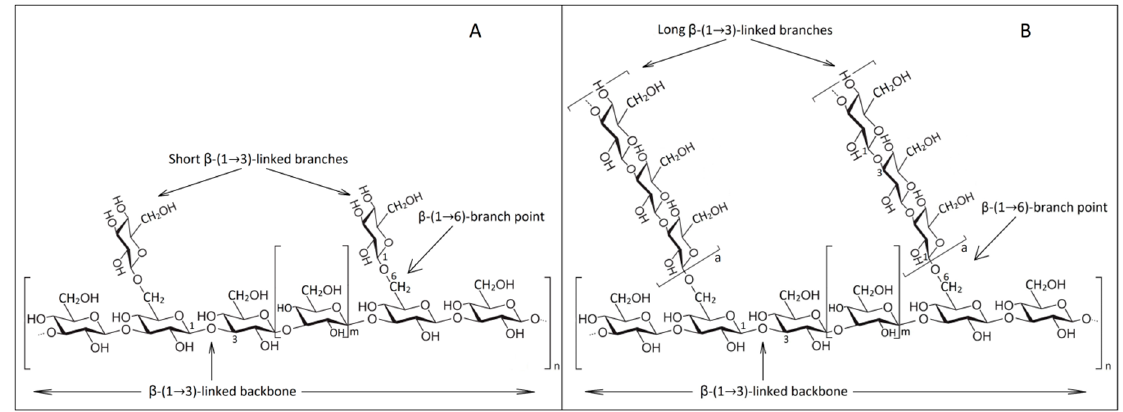
Figure 2. Schematic representation of yeast β -glucans: ( A ) soluble β -glucans; ( B ) insoluble β -glucans (adapted from [103,104]).